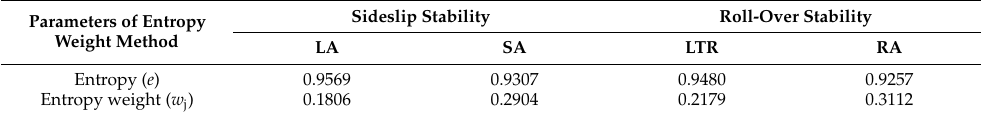
Table 6. Entropy weight of each indicator.